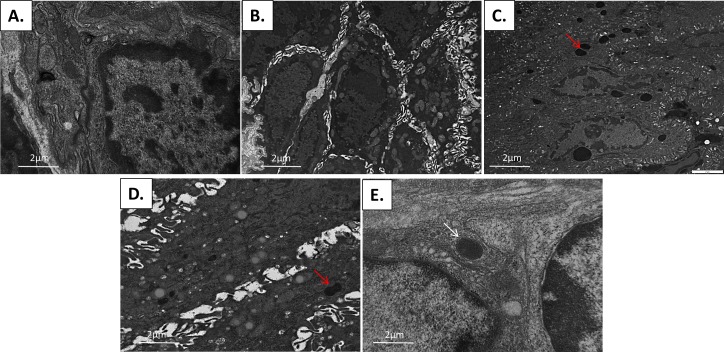
Electron microscopy following DMBA treatment.(A) Control K14E6/E7 animals with various organelles in normal quantities noted within the cell. (B) Following 5 weeks of DMBA treatment, there is an accumulation of mitochondria in the cell cytoplasm. (C) At 10 weeks, an accumulation of lysosomes is noted and is depicted with the red arrow. By 15 (D) and 20 (E) weeks of DMBA the accumulation of lysosomes is no longer present and there is evidence of autophagolysosomes (white arrow), which is formed after the autophagosome has fused with the lysosome.